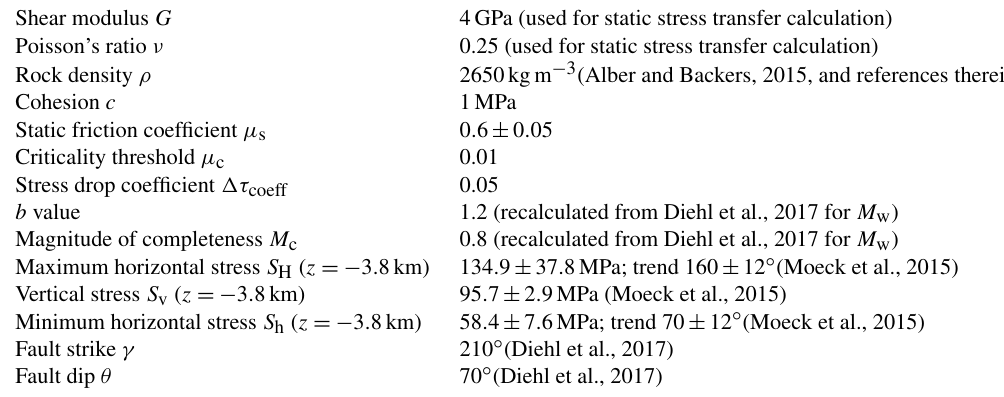
Figure 6. Initial conditions of the model: (a–c) Pressure at (a) y = 0, (b) y = 0 . 56, and (c) y = 1 . 17km along profile A–A (cid:48) in Fig. 2 (normal to the strike of the fault). The well is denoted by the dotted (open section) and solid (cased section) white line. (d–f) Gas saturation at (d) y = 0, (e) y = 0 . 56, and (f) y = 1 . 17km along the profile A–A (cid:48) in Fig. 2. The well is denoted by the red (open section) and blue (cased section) lines. The fault is illustrated by the thin dashed black lines, the fracture zone by the thick dashed black line, and the caprock by the solid black lines. Table 2. Parameters used for the seed